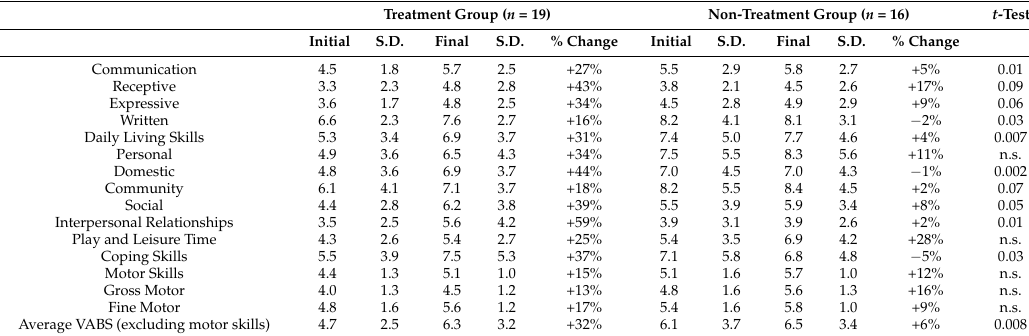
Table 5. Vineland Adaptive Behavior Scales II (VABS-II).